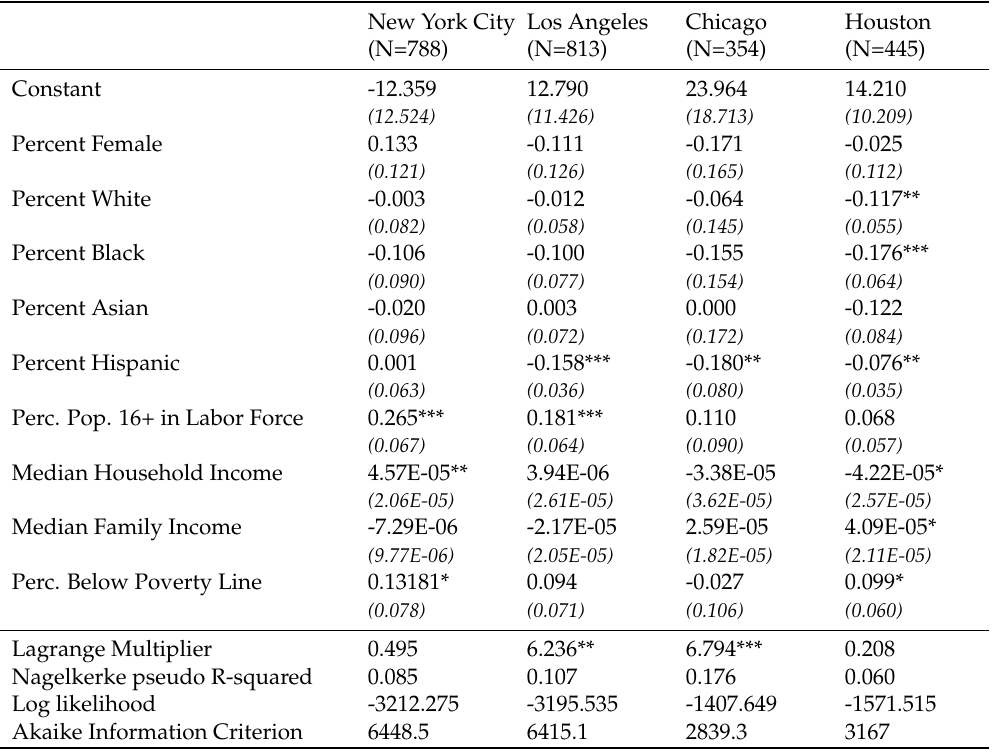
Table 9: Spatial error regression model results for change in visit duration to the Coffee Shop , place type split by